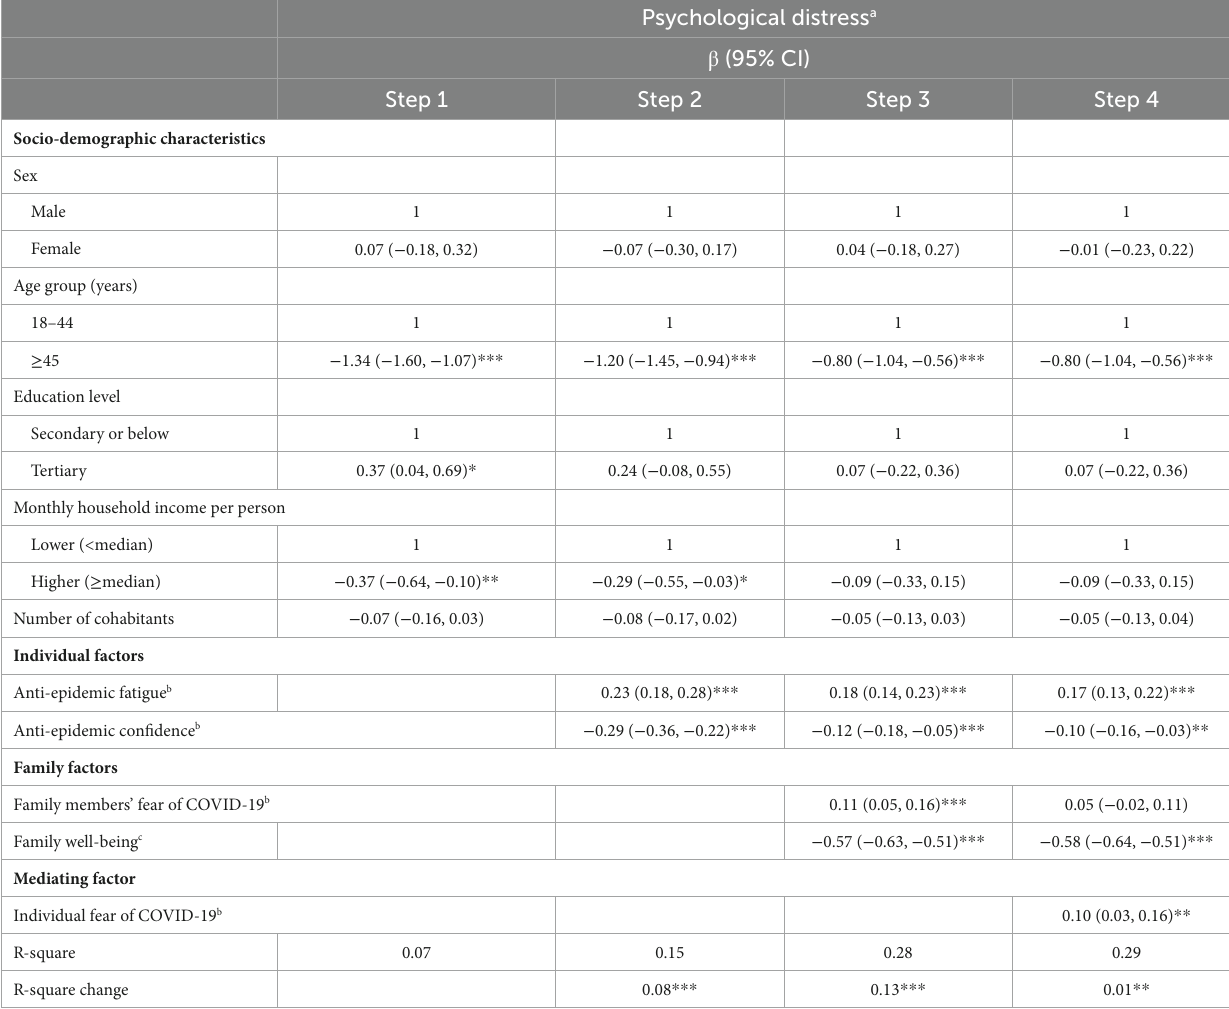
TABLE 2 Results of hierarchical regression examining the associations between individual and family factors with psychological